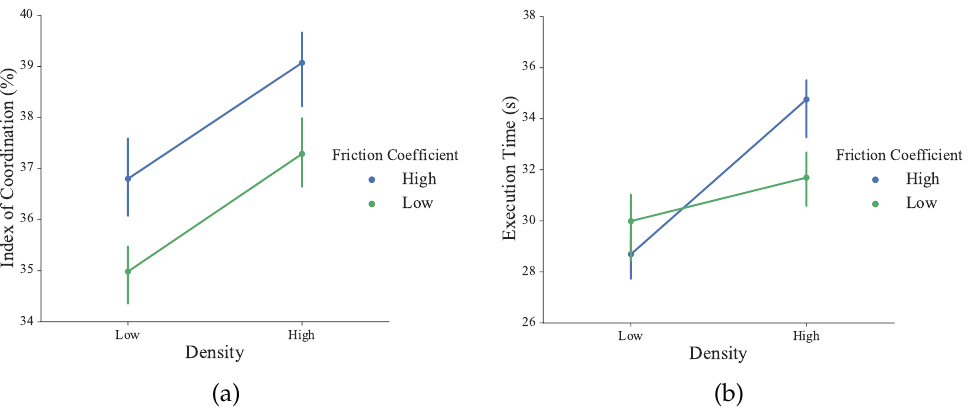
Figure 14. ( a ) The index of coordination of all subjects across all conditions in the factor plot; ( b ) Execution time of all subjects across all conditions in the factor